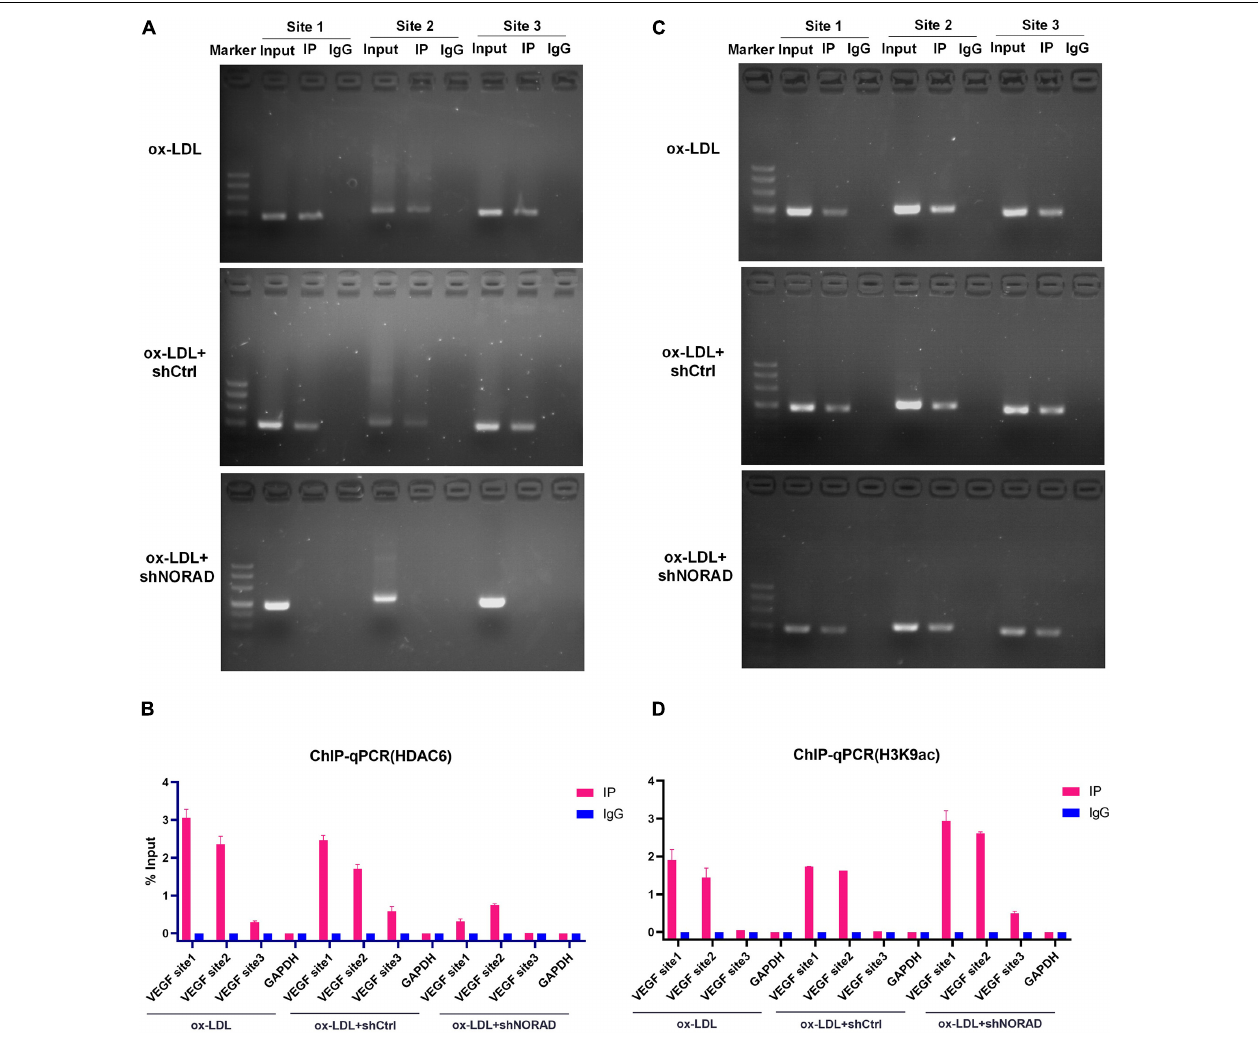
FIGURE 5 | Nucleus lncRNA NORAD suppresses VEGF gene transcription through enhancing H3K9 deacetylation via recruiting HDAC6 to VEGF gene promoter in ox-LDL-treated HUVECs. (A) Immunoprecipitated chromatin was analyzed by PCR for the VEGF gene promoter in HUVECs transfected with control shRNA or shRNA-targeting lncRNA NORAD under ox-LDL treatment. (B) Quantification of HDAC6 occupancy on the VEGF gene promoter by qRT-PCR in HUVECs transfected with control shRNA or shRNA-targeting lncRNA NORAD under ox-LDL treatment. (C) Immunoprecipitated chromatin was analyzed by PCR for the VEGF gene promoter in HUVECs transfected with control shRNA or shRNA-targeting lncRNA NORAD under ox-LDL treatment. (D) Quantification of H3K9ac occupancy on the VEGF gene promoter by qRT-PCR in HUVECs transfected with control shRNA or shRNA-targeting lncRNA NORAD under ox-LDL treatment. shRNA; shNORAD, shRNA-targeting lncRNA NORAD. N =